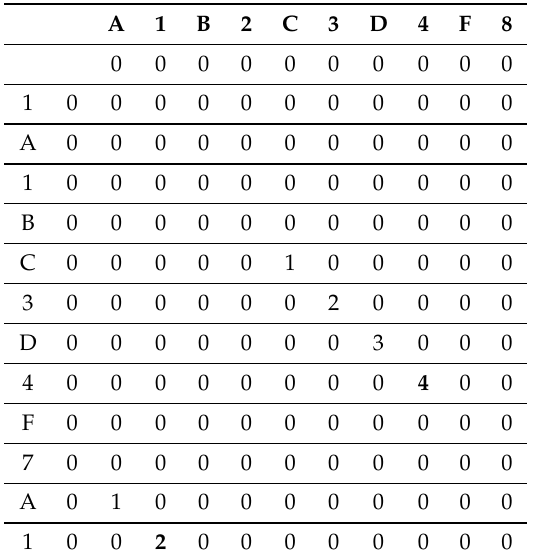
Table 2. Comparison array